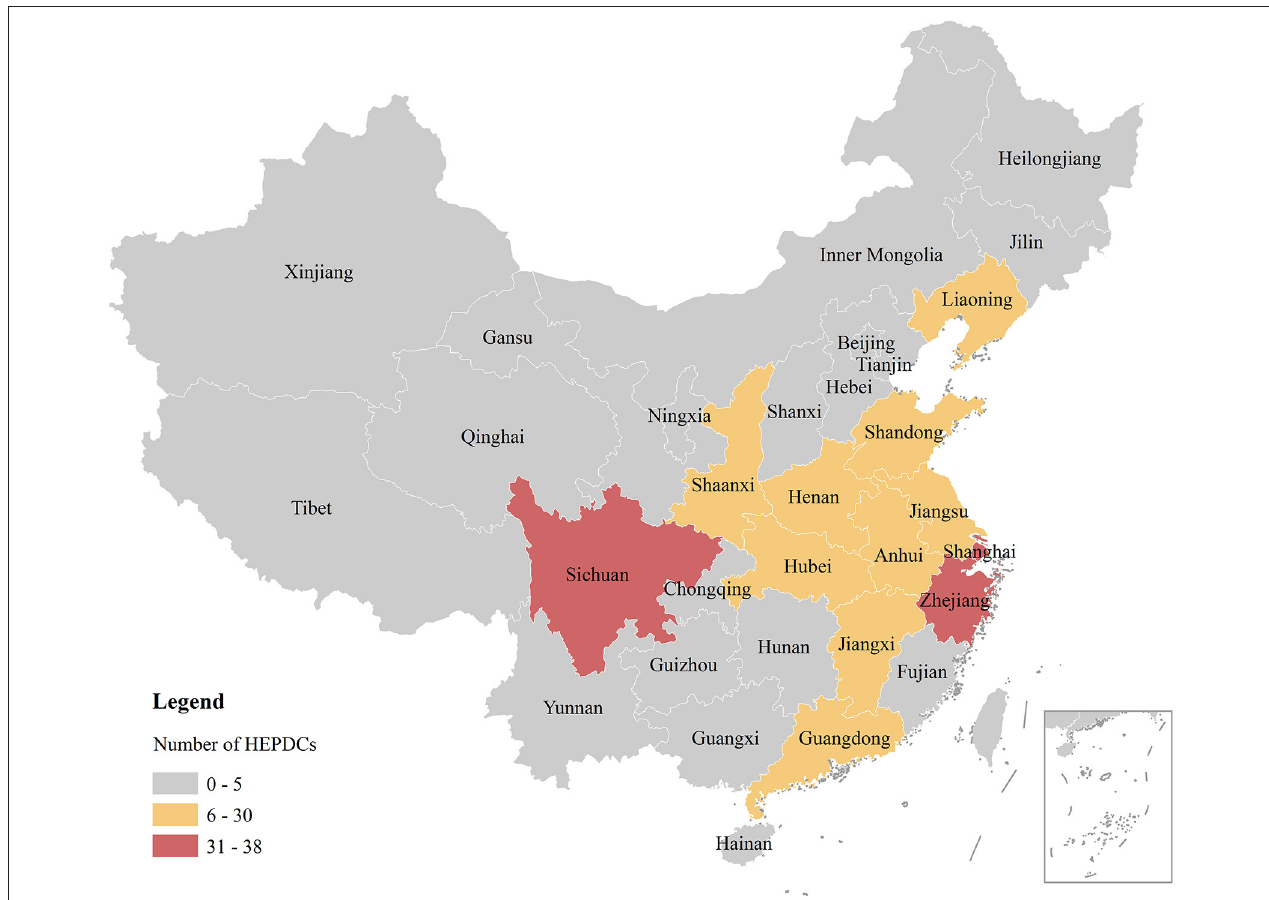
FIGURE 5 | Number of HEPDCs in China by province. Different background colors represent different numbers of projects. HEPDCs are Healthy Elderly care Pilot Demonstration Communities.